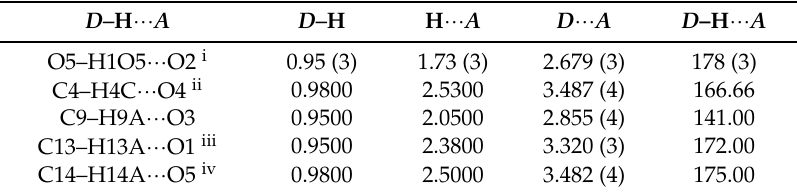
Table 5. Hydrogen-bond geometry (Å, ◦ ) of 2